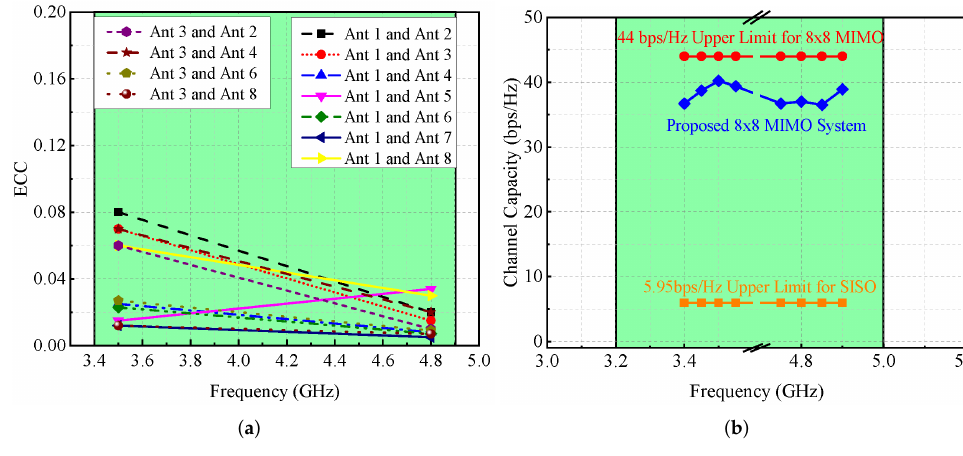
Figure 11. Modeled and actual radiation characteristics of MIMO antenna at ϕ = 90 ◦ for (a, b) Ant 1 at 3.4 GHz and 4.8 GHz, and (c, d) Ant 4 at 3.4 GHz and 4.8 GHz.